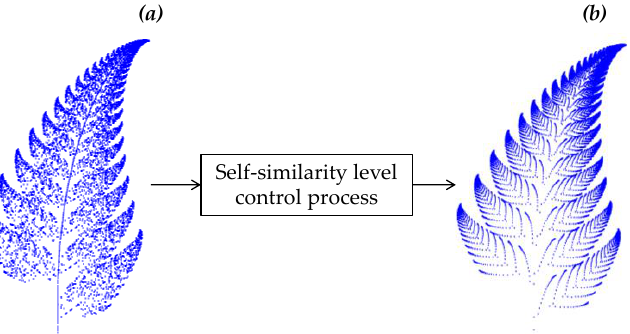
Figure 5. Concept of controlling self-similarity levels of a fractal: ( a ) original point cloud; and ( b ) point cloud controlled up to self-similarity level three.